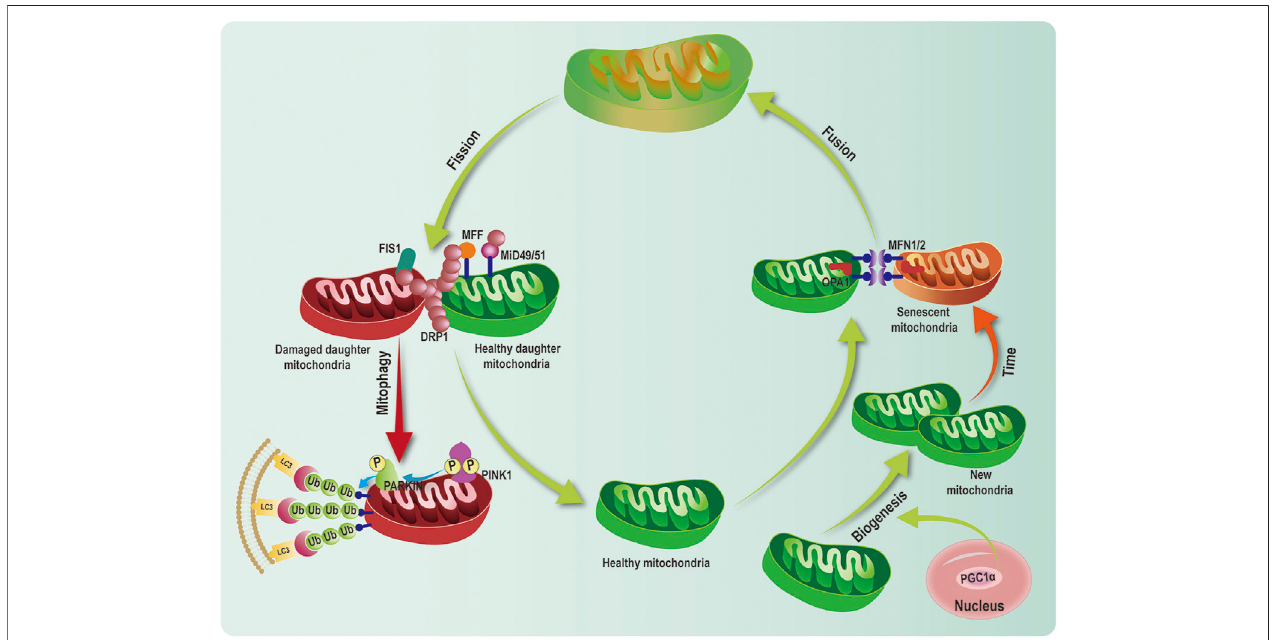
FIGURE 5 | Mitochondrial quality control network. Mitochondrial quality control (MQC) system consists of multiple processes including mitochondrial biogenesis, dynamics (fusion and fi ssion), and mitophagy. Peroxisome proliferator-activated receptor γ coactivator 1 alpha (PGC-1 α ), acted as critical transcriptional cofactor, activates mitochondrial biogenesis. Mitofusin 1/2 (MFN1/2) and optic atrophy1(OPA1) regulate mitochondrial fusion. Dynamin-related protein 1 (DRP1) and mitochondrial fi ssion factor (MFF), fi ssion 1(FIS1), mitochondrial dynamics proteins of 49 and 51 kDa (MiD49/51) modulate mitochondrial fi ssion. PINK1 and PARKINpathway is the classical ubiquitination dependent mitophagy pathway, which leads to mitophagy.